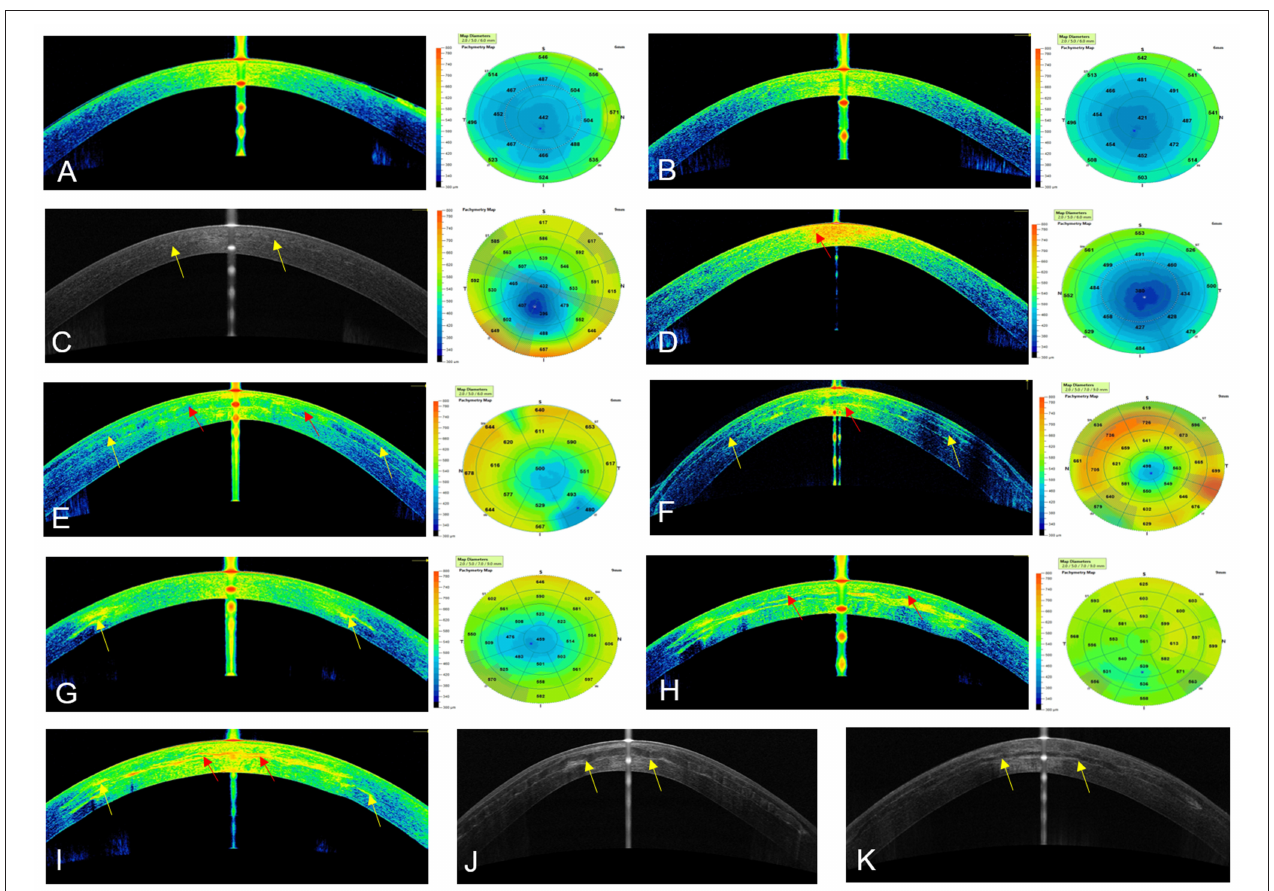
FIGURE 1 | Cornea Visante optical coherence tomography images and pachymetric maps. (A) Preoperative OCT in case 1, G-1. (B) OCT at 12 months post-op of the same patient, notice the transparency of the cornea. (C) OCT at 36 months post-op with case 2, G-1. Observe the transparency of the cornea, the (yellow arrows) demonstrate the limit of the flap. (D) Preoperative OCT in case 7, G-2, Notice the highly reflective area in the corneal stroma (red arrow). (E,F) OCT at 12 months and 36 postoperative in case 7. The improvement of the reflective band of neo-collagen in the periphery of the implanted lamina (yellow arrows) can be seen. The reflectance of the neo-collagen band (red arrow) is higher at 12 months in the center of the implanted lamina. (G) Preoperative OCT in case 13, G-3. The reflective paracentral scars can be noticed (yellow arrow). (H,I) OCT at 12 and 36 months post-op. The high reflectance of the neo-collagen band (red arrow) can be seen more evident at 36 months with this patient in the center of the lamina. Notice the improvement of the preoperative paracentral scars at 36 months post-op (yellow arrows). (J) OCT in Case9, G-2, and (K) in Case 12, G-3 at 36 months post-op. (yellow arrows) shows the limits of the